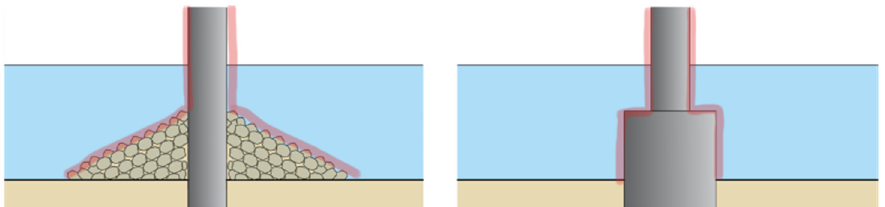
Figure 1. Similarity of outer contours between the riprap sloping structure ( left ) and complex piers ( right ), outlined in red.